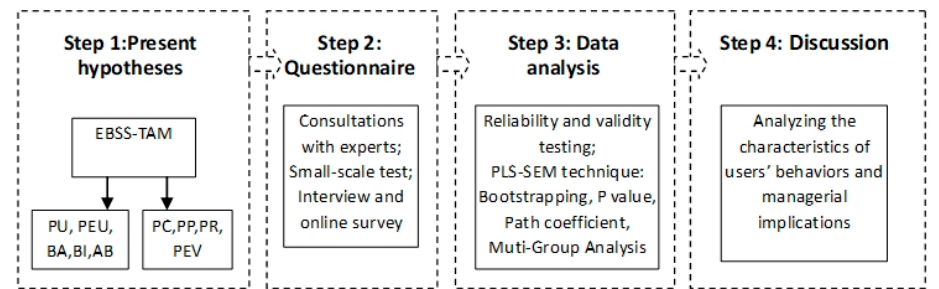
Figure 2. Study framework.